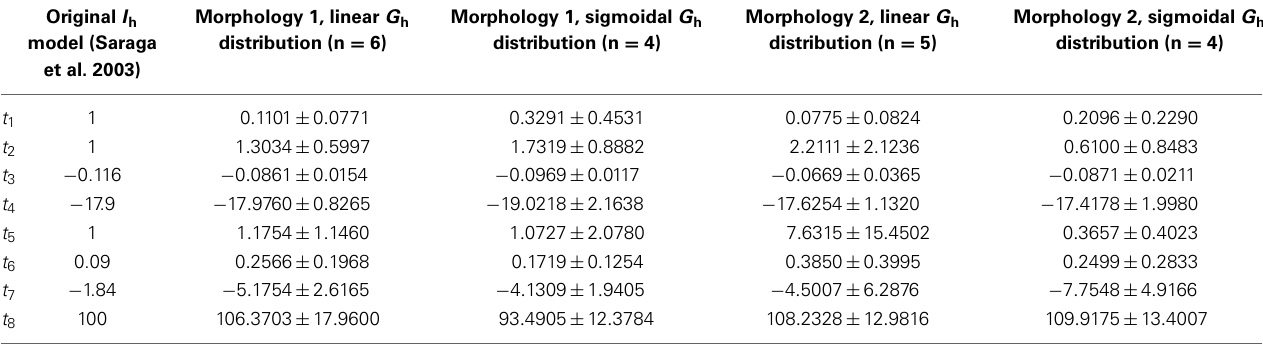
Table 4 | Fitted parameters for the activation time constant for I h